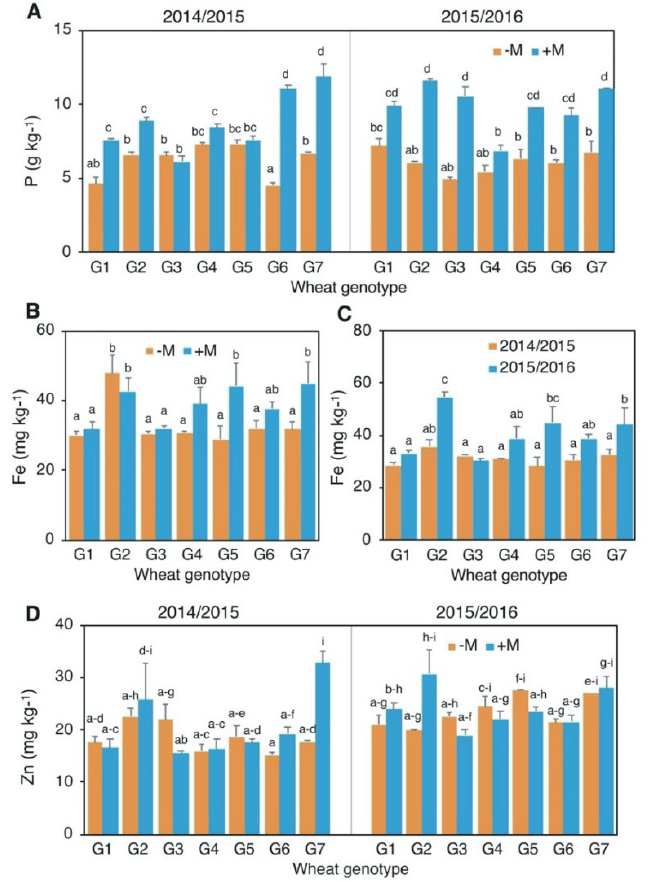
Figure 6. Effect of the interaction among wheat genotype (G), arbuscular mycorrhizal fungal inoculation (AMF), and year of cultivation (Y) (G × AMF × Y) on grain P ( A ) and Zn ( D ) concentration. Effect of the interaction G × AMF on grain Fe concentration ( B ) and of the interaction G × Y on grain Fe concentration ( C ). − M: mock-AM fungal inoculated treatment (control); +M: AM fungal inoculated treatment. Wheat genotypes: G1: Gentil Rosso; G2: Risciola; G3: Frassineto; G4: Autonomia B; G5: Verna; G6: Blasco; G7: Bologna. Data are mean ± SE. Different letters indicate significant differences at P < 5% according to Tukey B test.